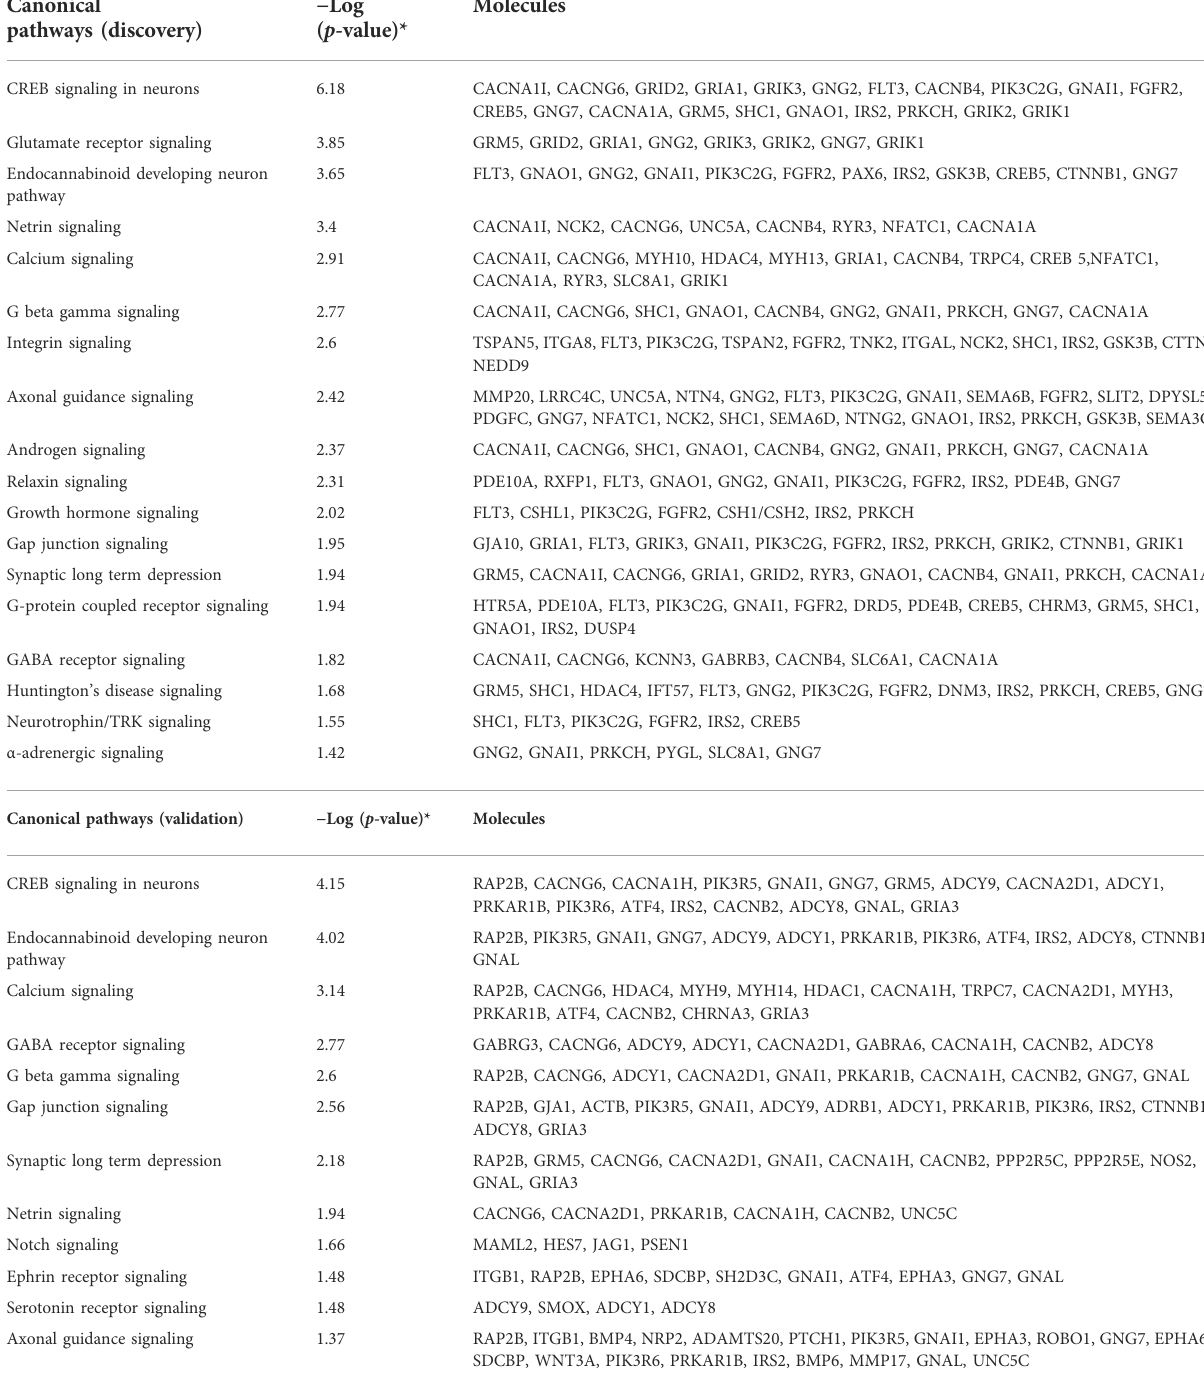
TABLE 2 Canonical pathways enriched among DDE DMR-associated genes from discovery and validation cohorts. Canonical pathways